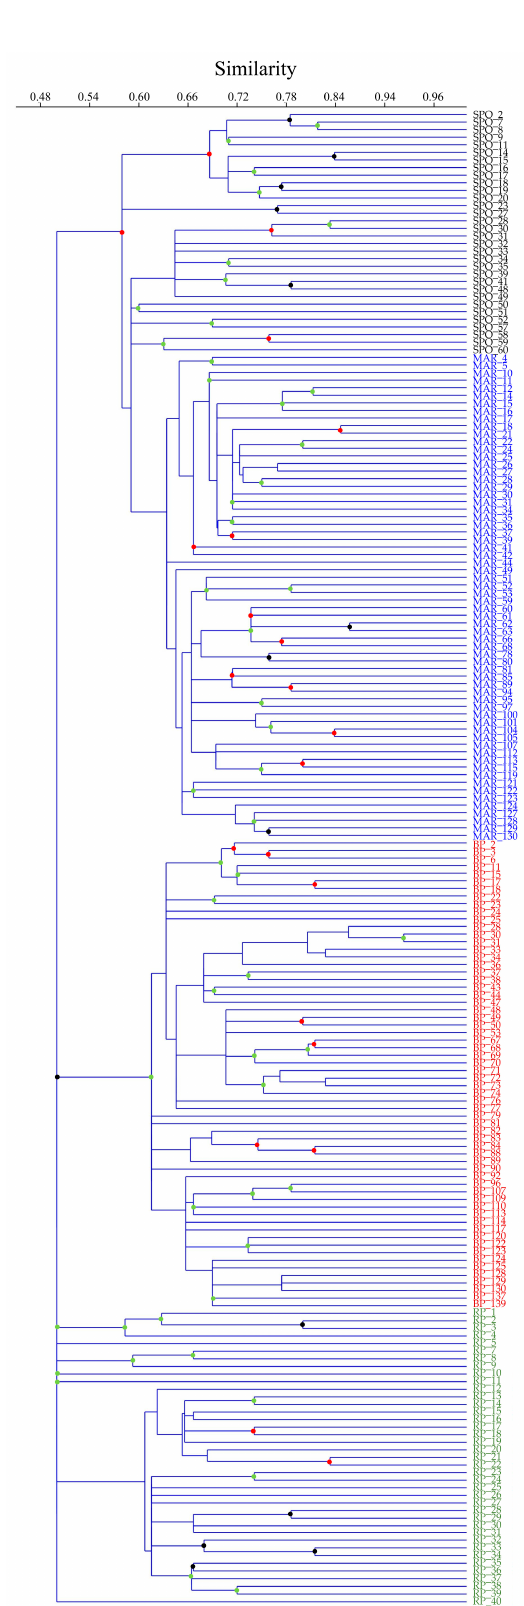
Figure 2. Constrained UPGMA tree of genetic similarity estimates computed among pairwise comparisons of corn accessions using the SSR marker data set, with nodes supported by bootstrap values. Black circle: bootstrap values ≥ 90%; red circle: 70% ≤ bootstrap values < 90%; green circle: 50% ≤ bootstrap values < 70%. The color scheme for the text is the same as for the symbols described in Figure 1 (black = Sponcio, blue = Marano, magenta = Biancoperla and green = Rosso Piave).